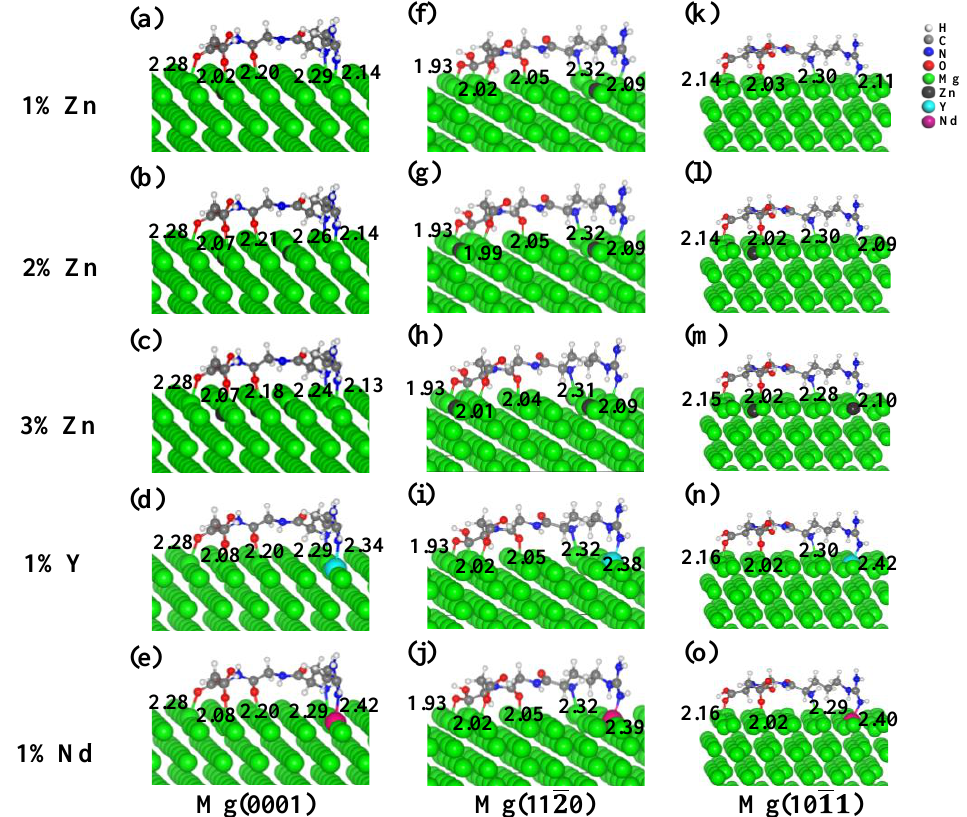
Figure 4. Optimized adsorption configurations of RGD on the Zn-, Y- and Nd-doped surfaces: ( a – e ) Mg(0001) surfaces, ( f – j ) Mg(1120) surfaces and ( k – o ) Mg(101 1) surfaces. The bond lengths (in Å) are also listed.